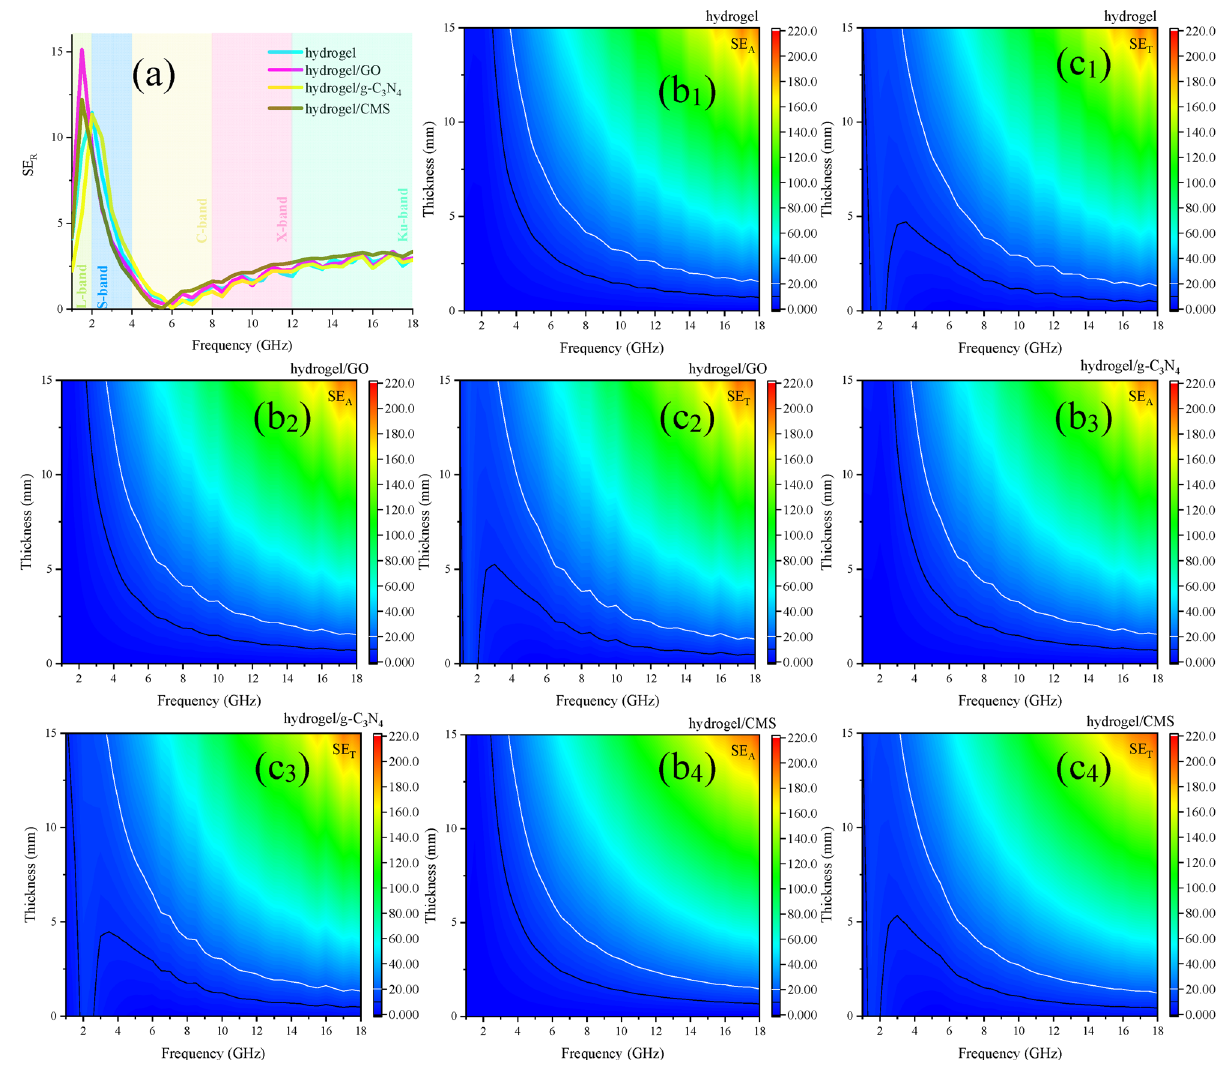
Figure 9. SE R ( a ), SE A ( b 1–4 ), and SE T ( c 1–4 ) of the hydrogel containing